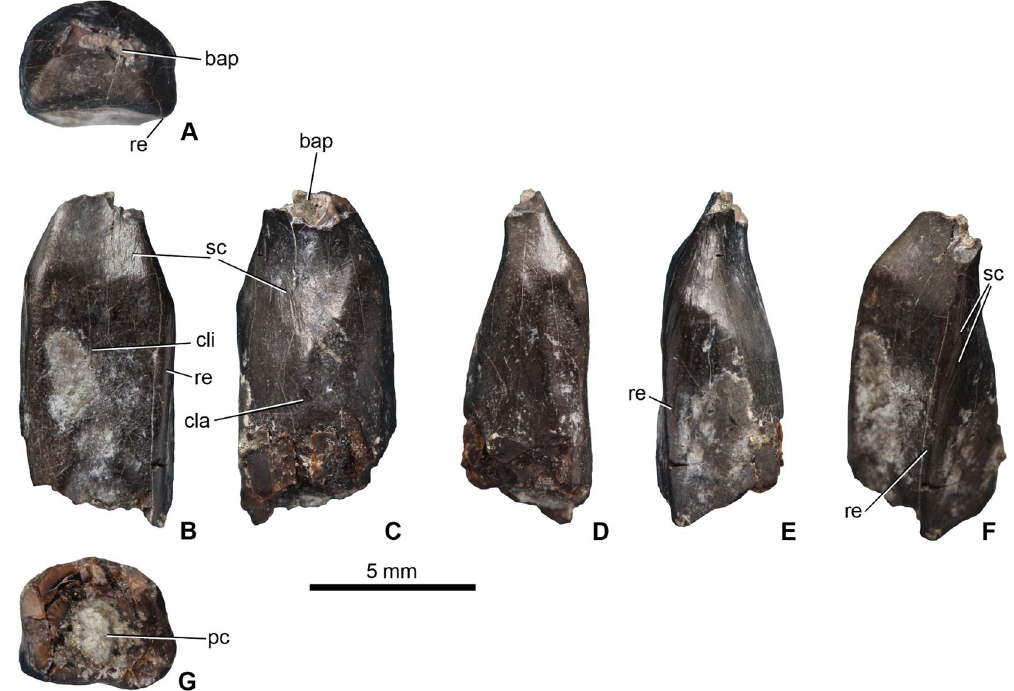
Figure 2. Basal titanosauriform tooth (MTM PAL 2017.1.1.) from the Santonian of Iharkút, Hungary. ( A ) apical, ( B ) lingual, ( C ) labial, ( D ) mesial, ( E ) distal, ( F ) oblique distolingual, and ( G ) basal views. Abbreviations: bap, broken apex of the crown; cla, convex labial surface; cli, slightly concave lingual surface; pc, pulp cavity; re, rounded edge; sc,